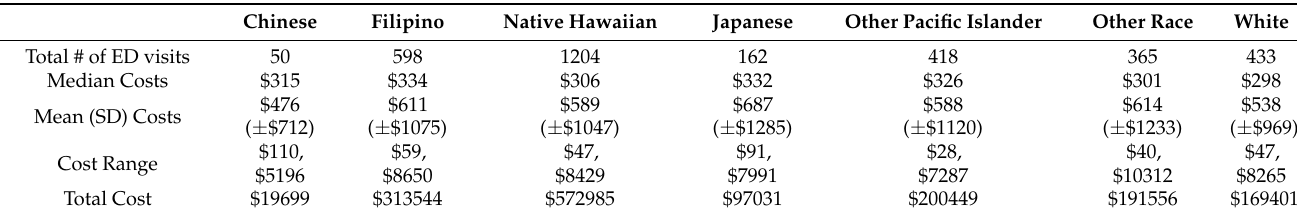
Table 4. Descriptive data for all potentially preventable ED Visits for Asthma by Race or ethnicity in Hawai‘i from Hawai‘i Health Information Corporation Data, 2015–2016 a